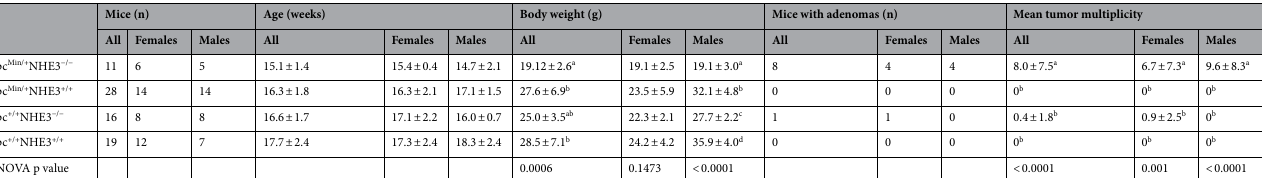
Table 1. Number of mice in the study, their age, body weight, the number of adenomas and tumor multiplicity for each genotype. Statistical differences between genotypes for body weight and tumor multiplicity were analyzed with one-way ANOVA test followed by Tukey’s multiple comparison